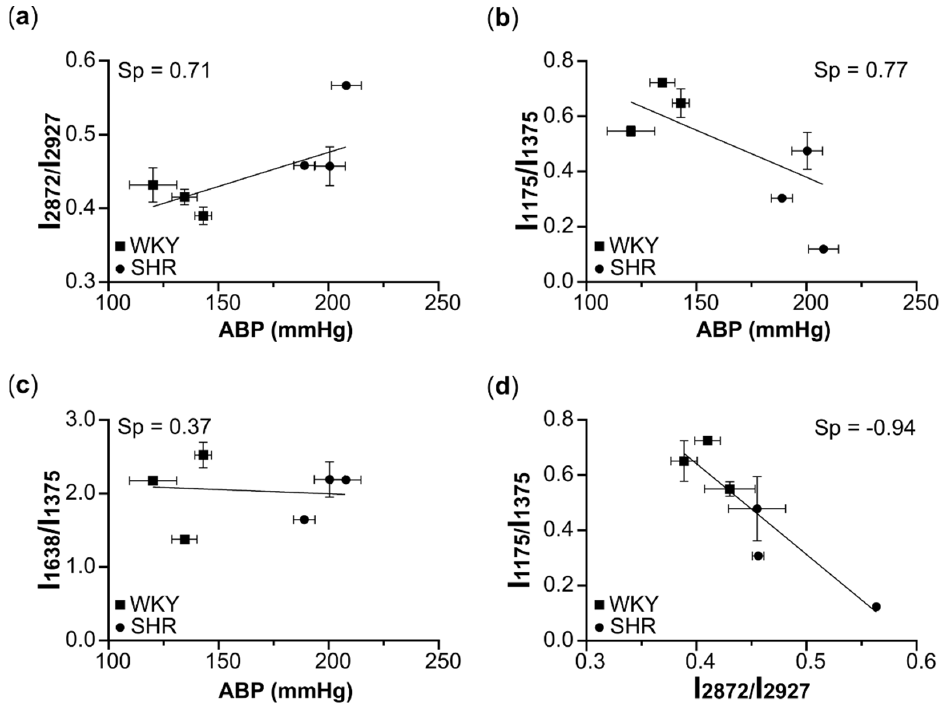
Figure 4. Correlations between different SERS parameters. ( a–c ) Correlations between arterial blood pressure (ABP) ( x -axis) and the ratios ( y -axis) of peak intensities in the SERS spectra of erythrocyte ghosts from WKY (squares) and SHR (circles) rats. ( d ) Correlation between the ratios corresponding to in-plane Hb heme mobility and the stiffness of plasma membrane of erythrocyte ghosts. Sp, Spearman correlation coefficient.